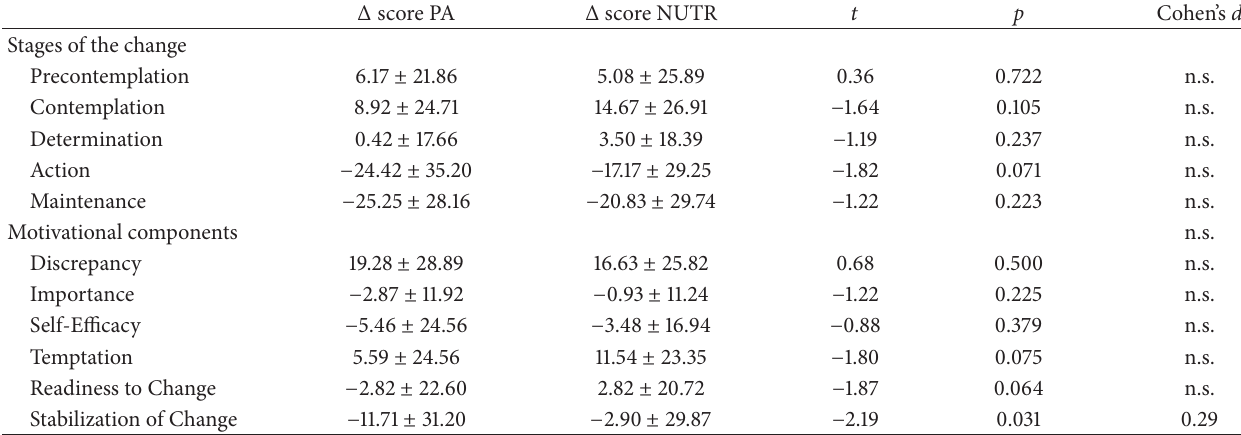
Table 4: Paired Student’s 𝑡 -test Δ score of stage of change and motivational habitual physical activity and healthy nutrition. Data are presented as mean ± SD. Actual score changes are